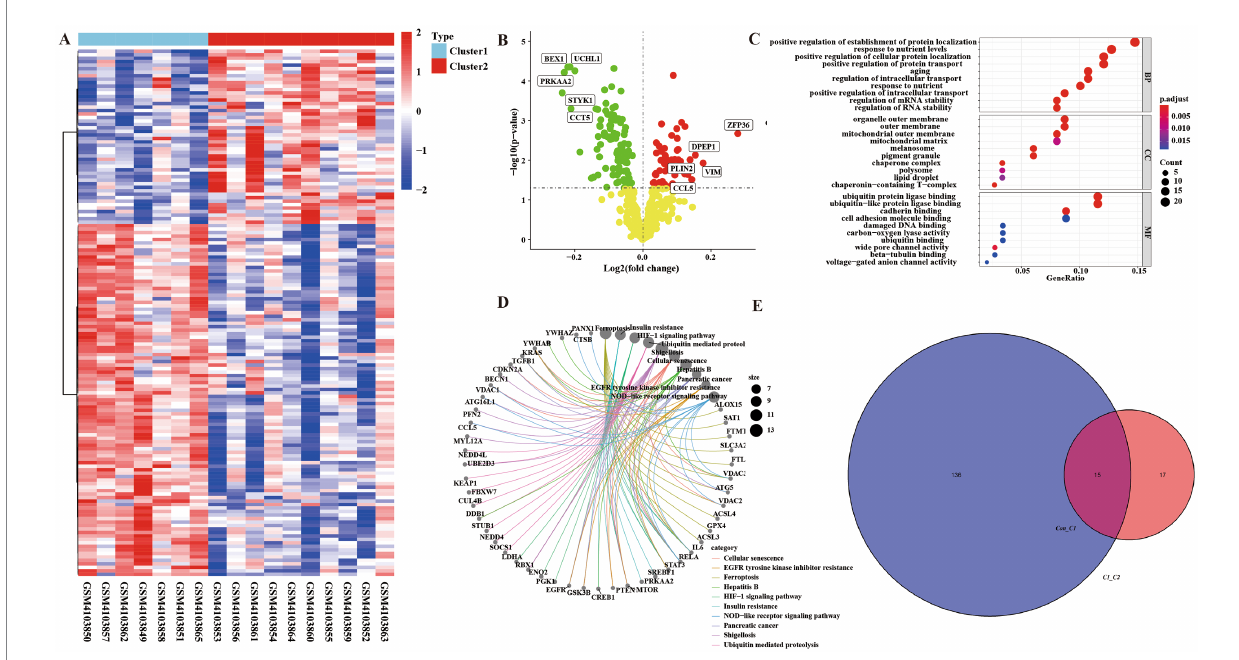
FIGURE 4 There were ferroptosis-related differentially regulated genes among the integrated control group, Cluster 1 group, and Cluster 2 group. (A) Heatmap of differential genes in Cluster 1 group and Cluster 2 group enrichment analysis. (B) Volcanic map of differential genes in Cluster 1 group and Cluster 2 group enrichment analysis. (C) Bubble map of GO analysis of differential genes between Cluster 1 and Cluster 2 groups. (D) KEGG pathway diagram of differential gene enrichment analysis between Cluster 1 group and Cluster 2 group. (E) Venn diagram of ferroptosis-related crossover genes between control group and Cluster 1 group, Cluster 1 group, and Cluster 2 group.